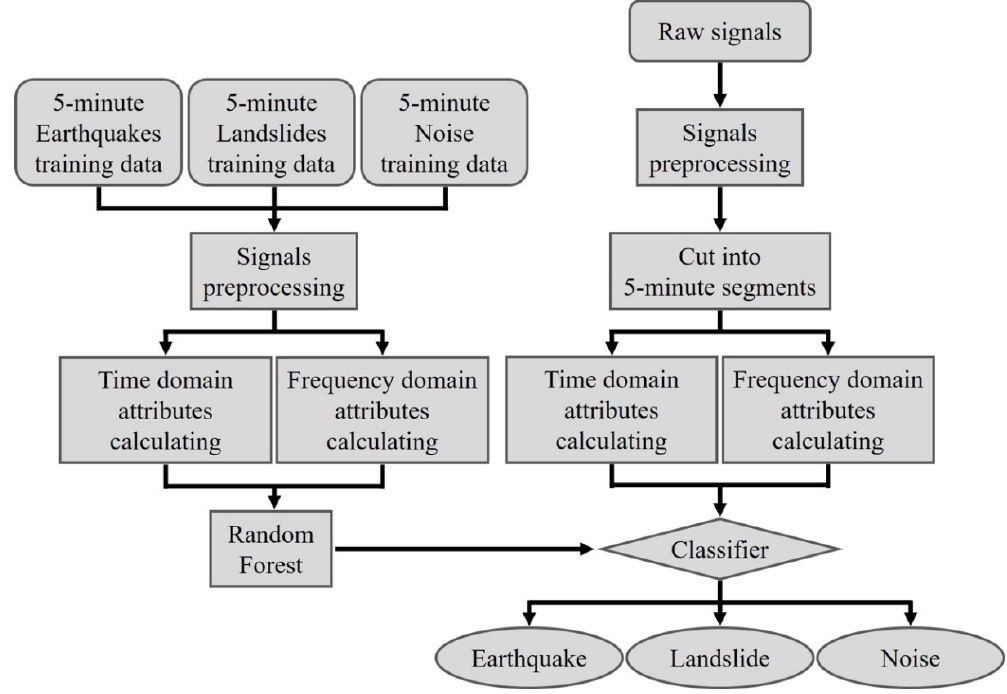
Figure 4. Flowchart of classifier creation and application.